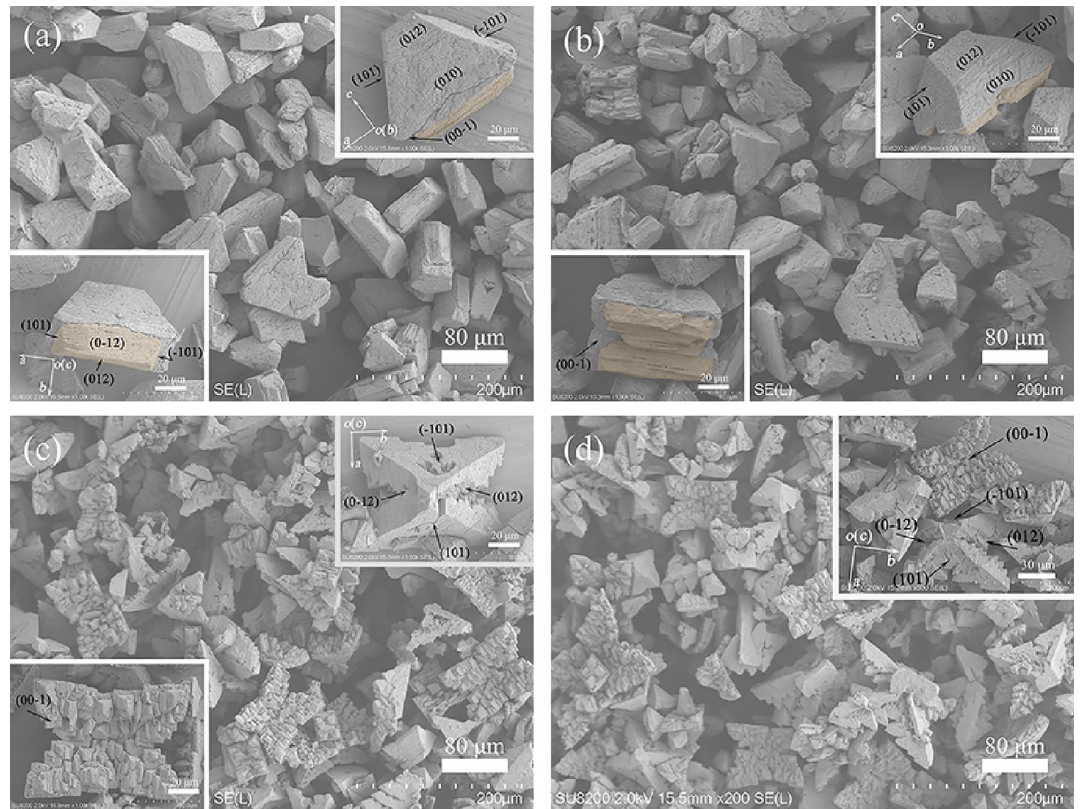
Figure 2. Typical FESEM images of the struvite obtained at a mineralization time of 3 ( a ), 5 ( b ), 8 ( c ), or 15 d ( d ). The overgrown crystals were colored with orange, and the same coloring was also adopted in following